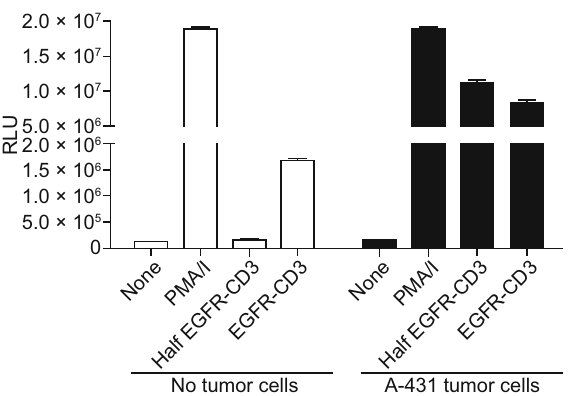
Figure 5. Conditional activation of T cells by anti-EGFR/ anti-CD3 Half DVD-Ig. Activation of NFAT reporter in Jurkat T cells by anti-EGFR/anti-CD3 DVD-Ig and anti-EGFR/anti-CD3 Half DVD-Ig molecules in the presence or absence of A-431 tumor cells that express EGFR. PMA plus ionomycin (PMA/I) stimulation is included as a